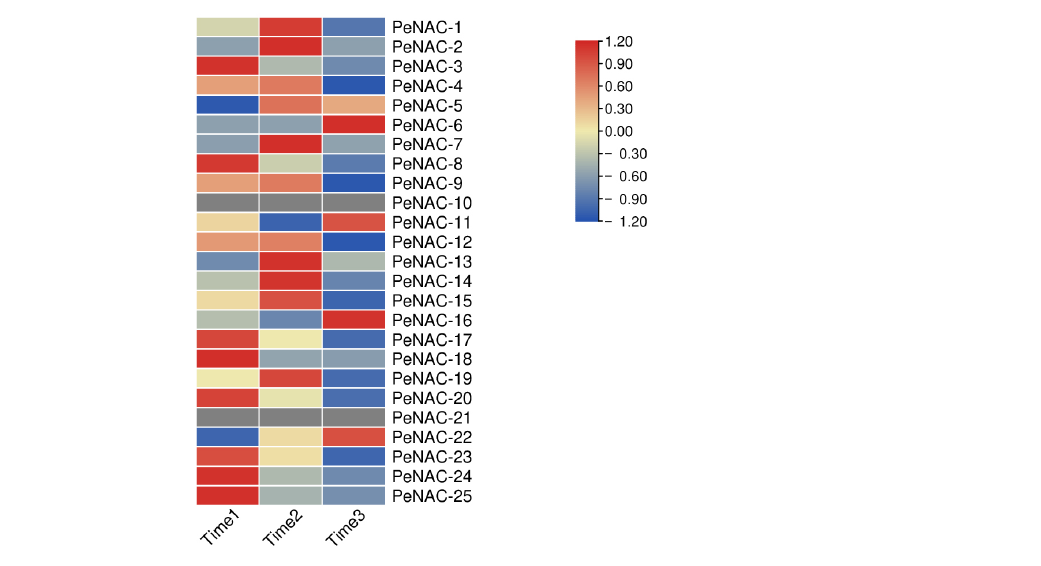
Figure 4. Expression profiles of PeNACs genes during three fruit-ripening periods (Time1: the 7th day before fruit harvest, Time2: the harvest period, Time3: the 7th day after fruit harvest). The details are shown in Table S3. A low expression level is shown in blue and a high expression level is shown in red. The heat map was generated using TBtools.